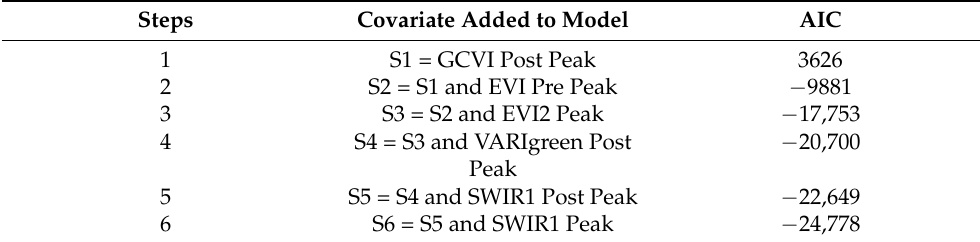
Table 4. AIC summary for models in stepwise analysis. Covariate sets are referred to as S1–S6.